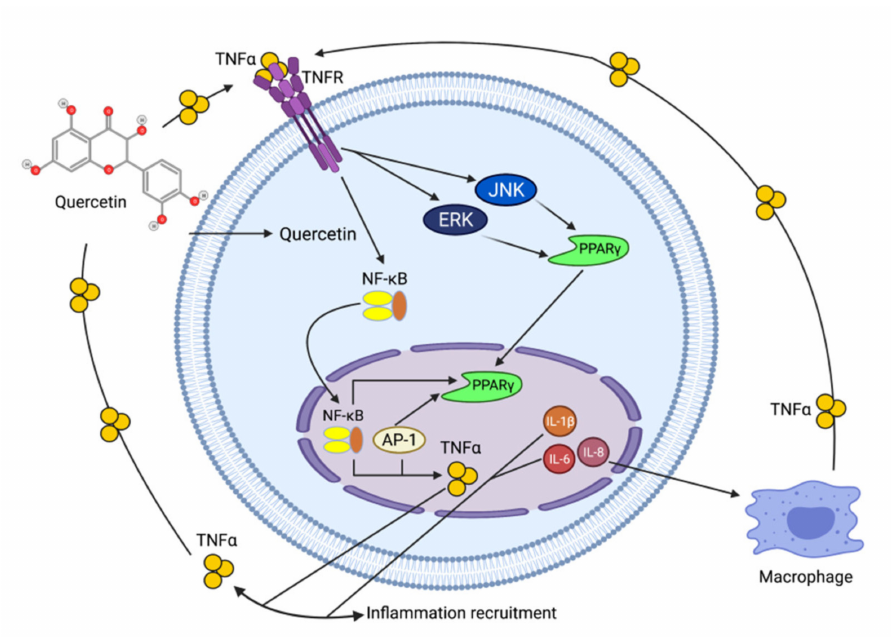
Figure 11. Working model on how quercetin blocks tumor necrosis factor- α (TNF α )-mediated inflammation (Modified from